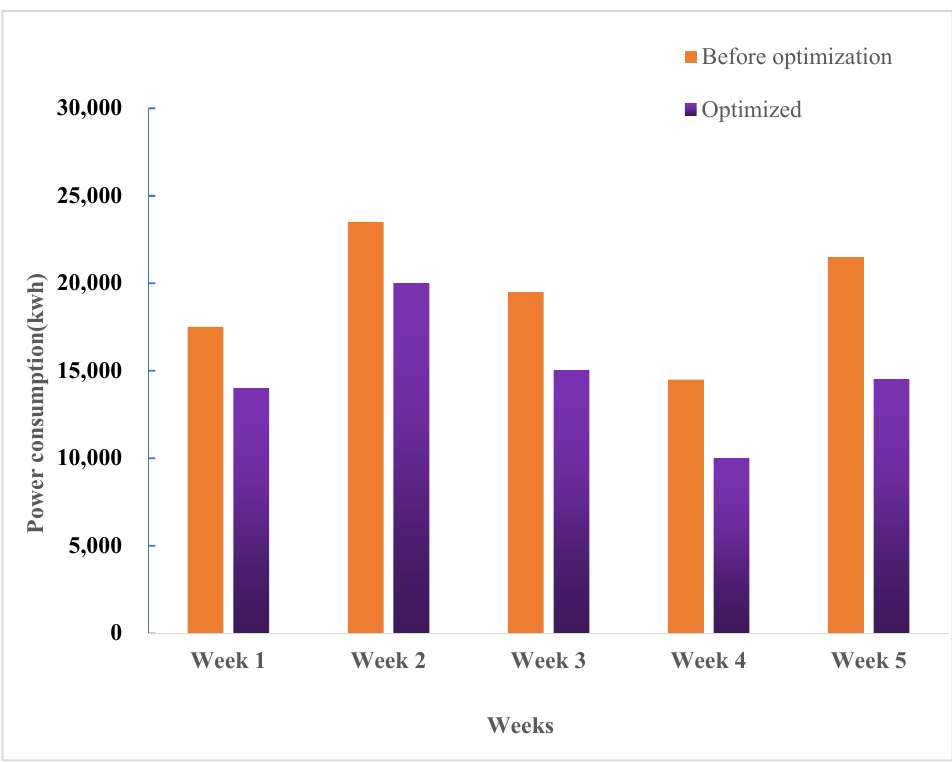
Figure 5. The electricity consumption of the sewage treatment in Factory A within 5 weeks.